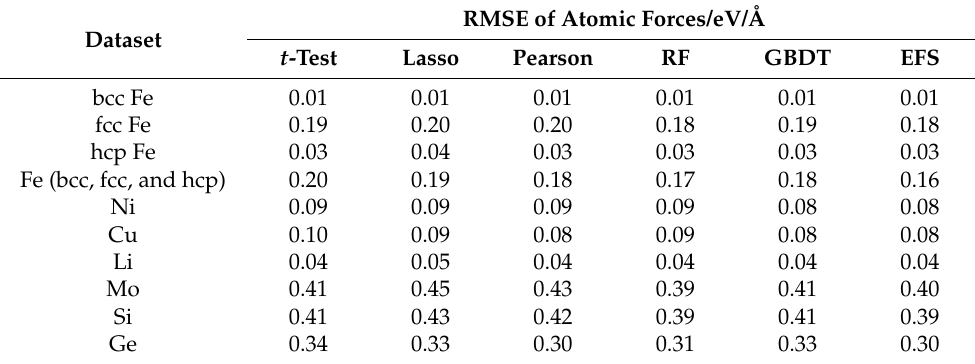
Table 5. Force RMSE comparison between EFS and benchmark methods on